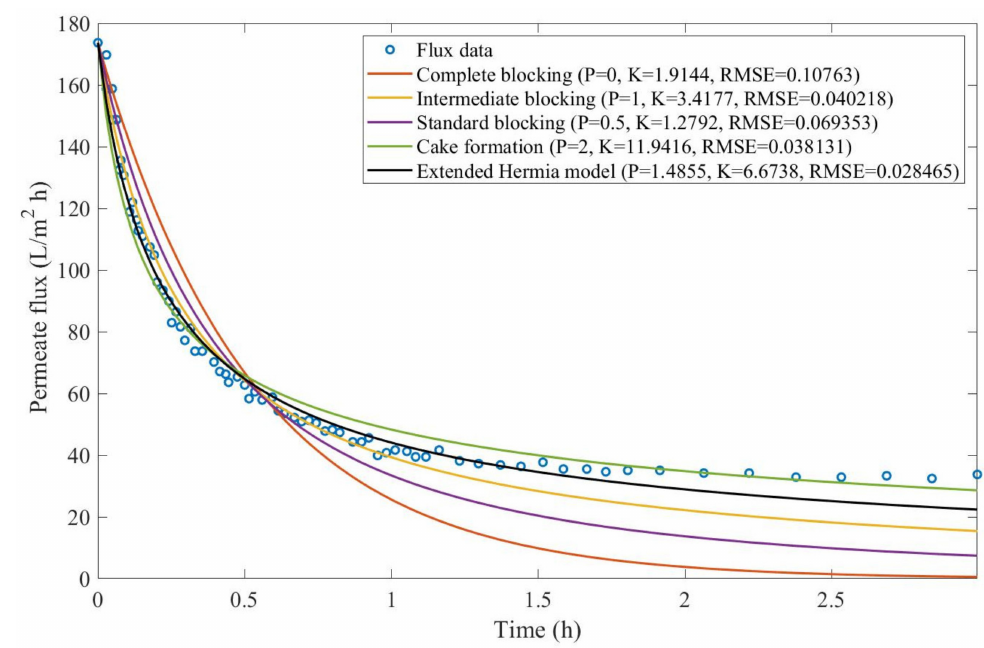
Figure A9. Model fitting for corn syrup microfiltration with CM08 at 0.5 m/s and 50 kPa considering the four original pore-blocking mechanisms and the extended Hermia model